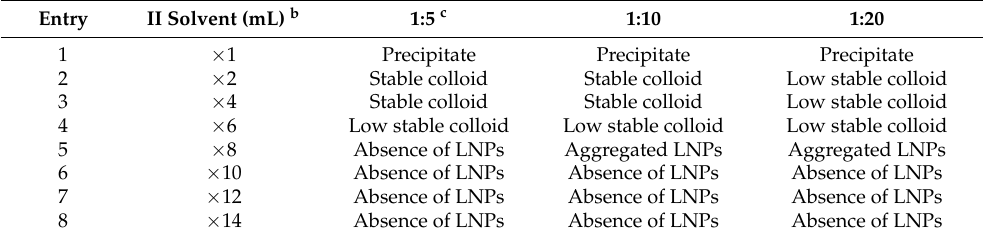
Table 3. Preparation and loading of biomimetic thymine dimer 4a into LNPs by nanoprecipitation technology a